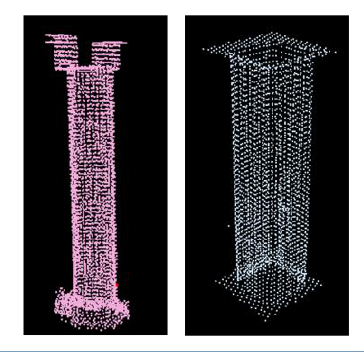
Figure 5. Image of two automatically segmented columns: round cross-section ( left ) and rectangular cross-section ( right